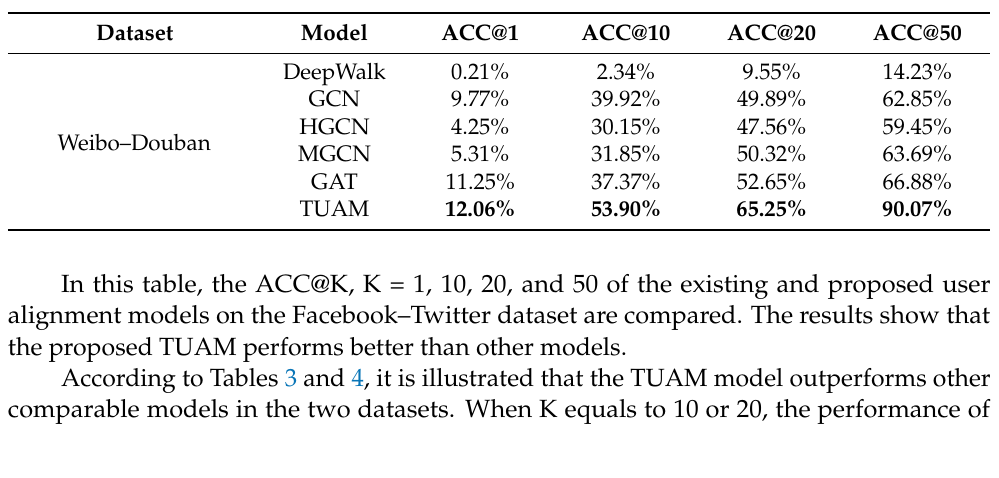
Table 4. The performance of different methods on ACC@K on the Weibo–Douban